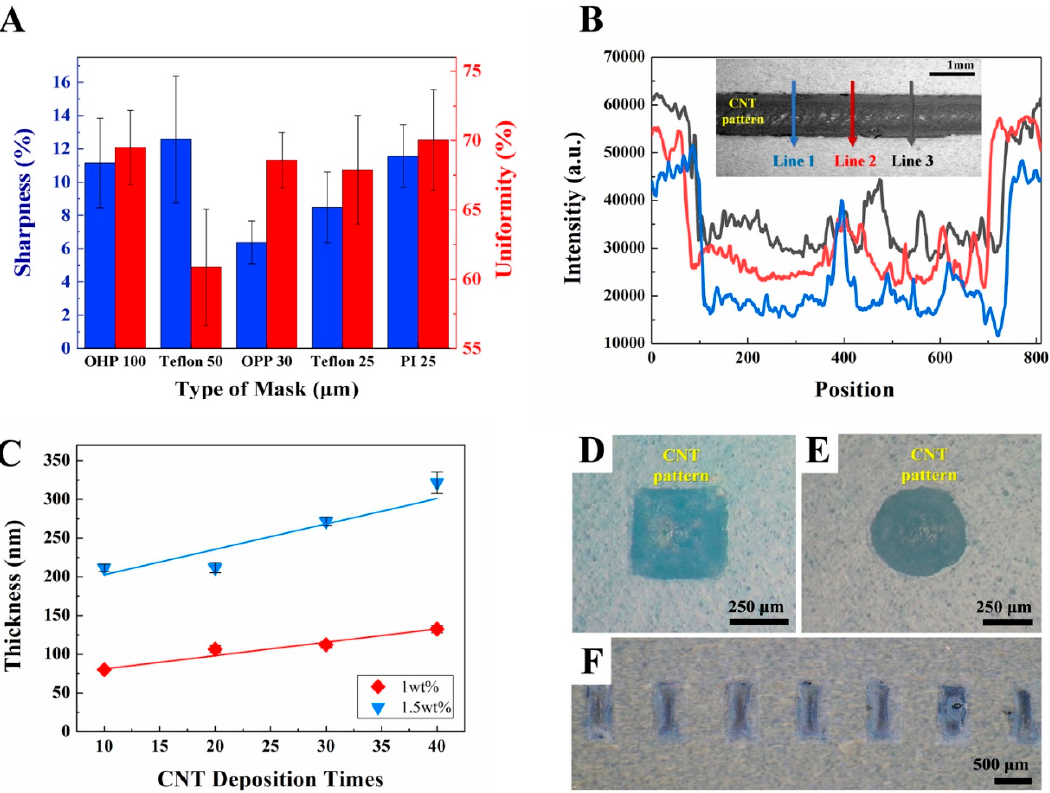
Figure 3. Optical properties and thickness of CNT films deposited on elastomer substrate by meniscus-dragging deposition (MDD) for mask selection and showing the thickness and types of patterns, which can be formed by direct patterning. ( A ) The average values and standard deviation of sharpness (blue, %) and uniformity (red, %) of CNT patterns are varied by masking materials. ( B ) Optical image of CNT with marked lines and intensity of line profiles when the “OPP 30” mask was used. ( C ) Thickness of the 1 wt% CNT layer (red) and 1.5 wt% CNT layer (blue) based on the number